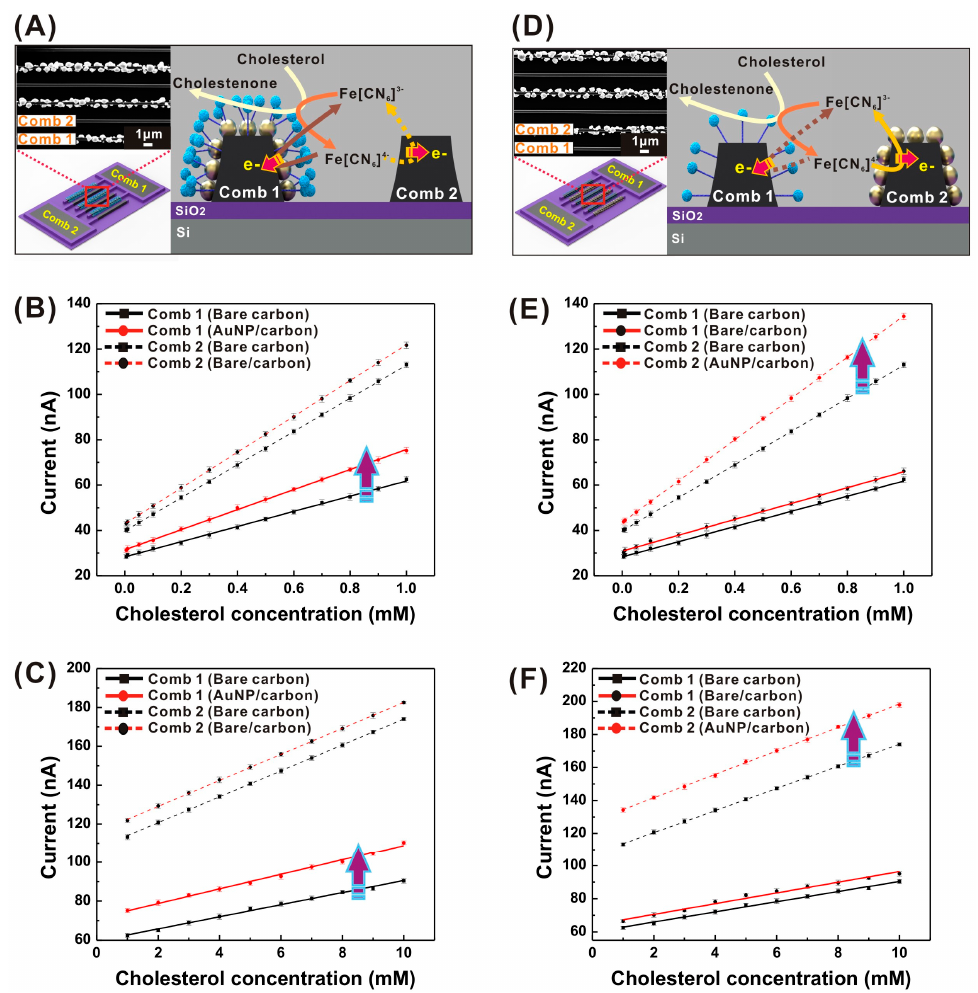
Figure 8. Schematic sensing mechanisms and SEM images of carbon IDEs selectively modified with AuNPs at a single comb, and those cholesterol sensing results: ( A – C ) comb 1: AuNP/carbon comb, comb 2: bare carbon comb; ( D – F ) comb 1: bare carbon comb, comb 2: AuNP/carbon comb. Calibration 1–10 mM cholesterol in 50 mM PBS containing 10 mM [Fe(CN) 6 ] 3 − (applied potential = 0.6 V;